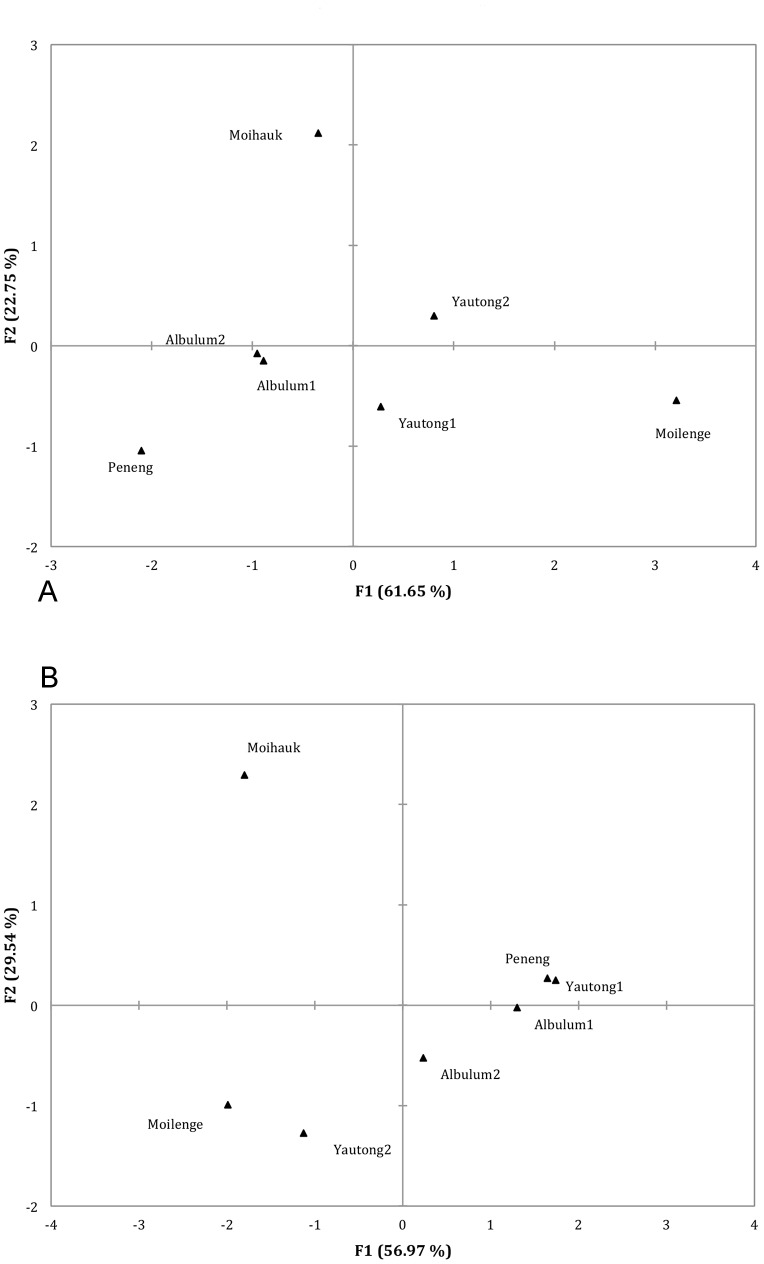
Multidimensional scaling analysis of genetic structure.Multidimensional scaling analysis of relationships among host villages based on genetic differentiation. We had the power to detect significant genetic differentiation between host villages 91% of the time when it existed [47]. Power for ΦST-V was <50% given a cut off of ΦST-V = 0. To have power equal to 90% we treated all values of ΦST-V relative to 0.0177 as undifferentiated. The X-axis and Y-axis represent the percent of variation explained by each dimension. A) ΦST-V the measure of genetic differentiation based on sequence distance [28] and B) DJ-V the measure of genetic differentiation based on allele frequencies [31].